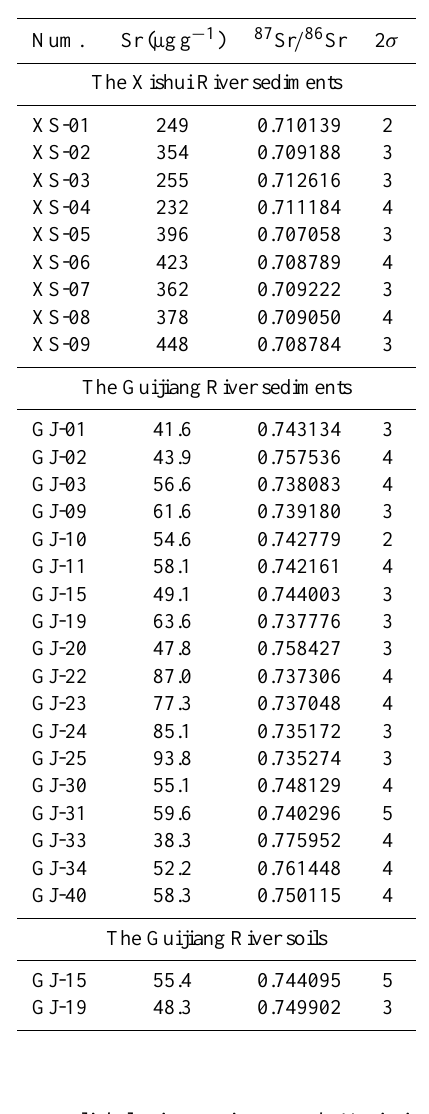
Table 4. Sr isotopic compositions of underlying bedrocks in the Xishui River and Guijiang River